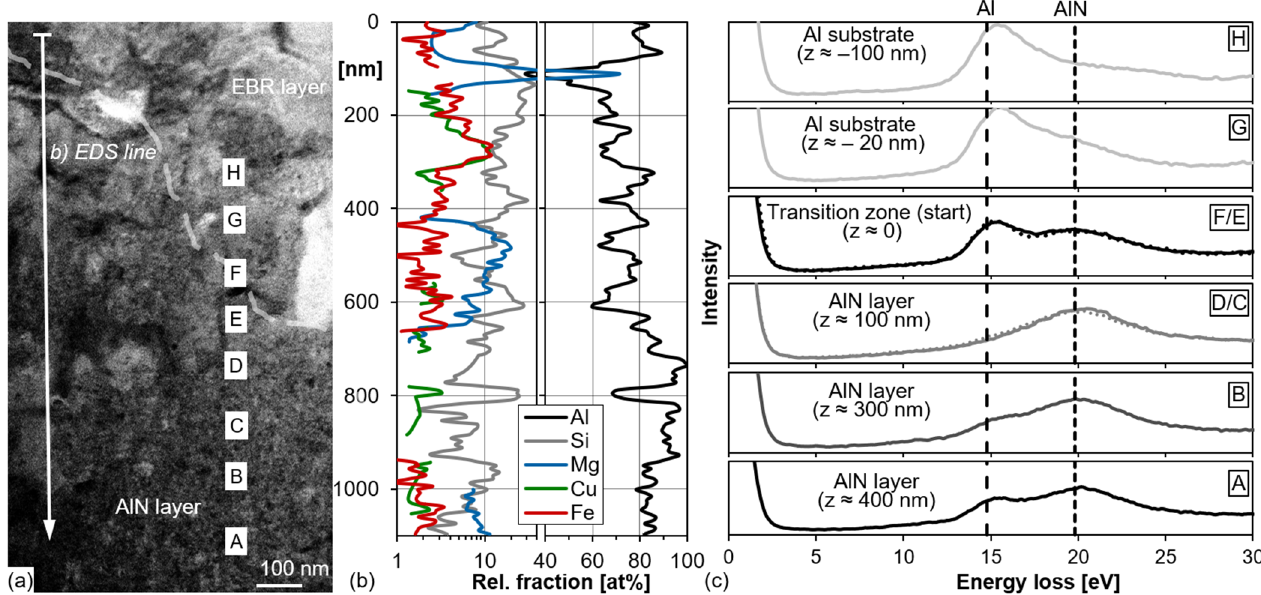
Figure 6. Analysis at the transition zone between AlN and the EBR layer: ( a ) TEM image (bf) of the area investigated marked with EDS and SAED measuring points (A–H) at the different distances z, given in the partial images; ( b ) EDS profiles (note: without N and O); ( c ) EEL spectra measured.